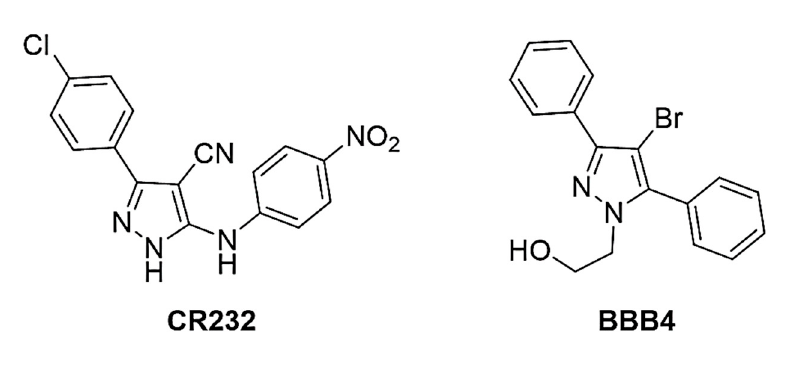
Figure 1. Chemical structure of CR232 and BBB4.